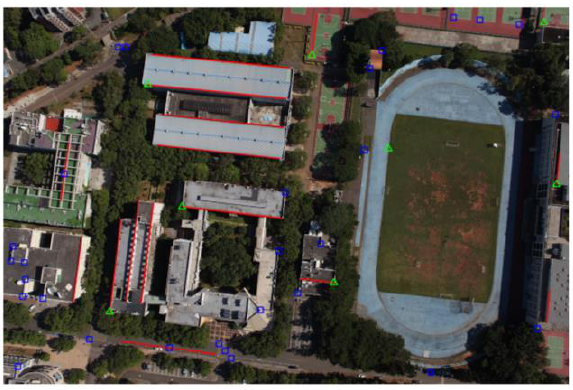
Figure 6. Distribution of control